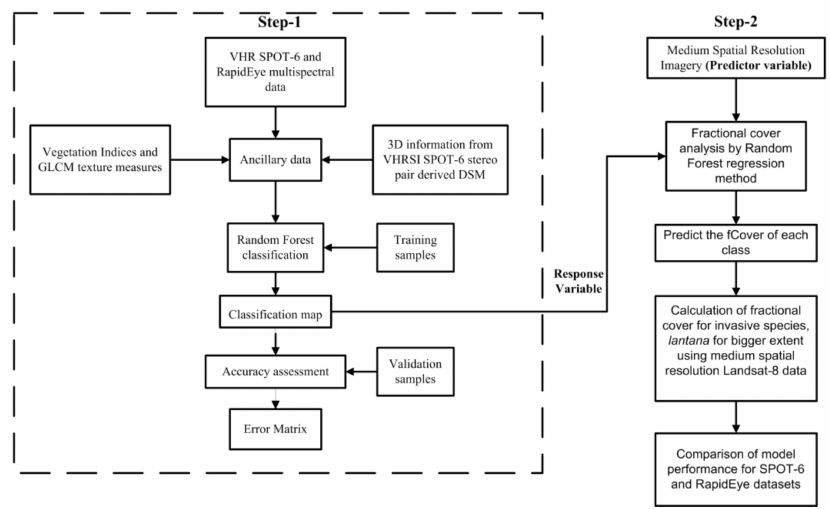
Figure 2. Workflow diagram for classification (Step-1) and fractional cover analysis